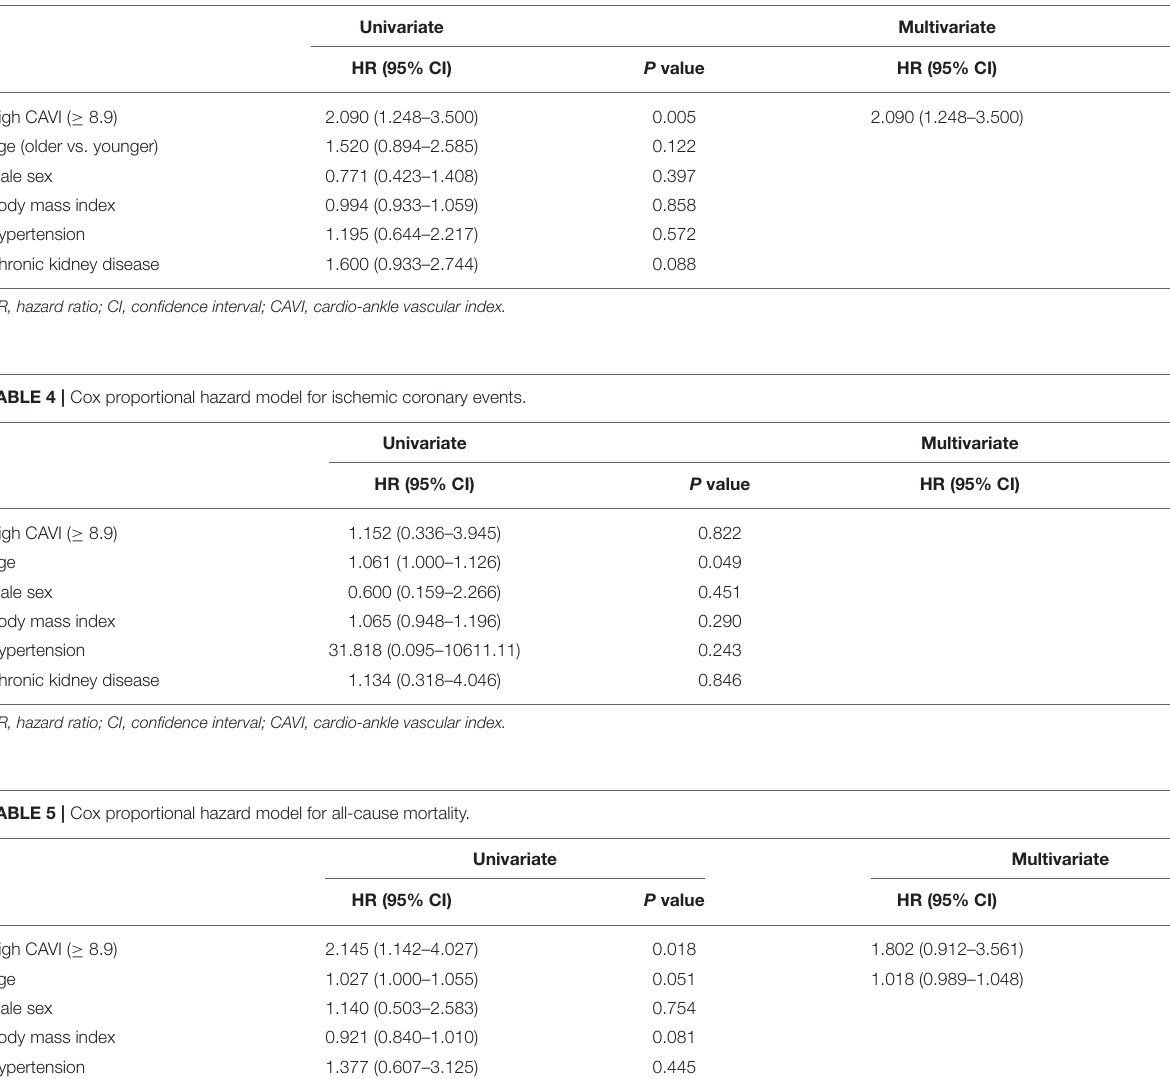
TABLE 3 | Cox proportional hazard model for cardiac events.